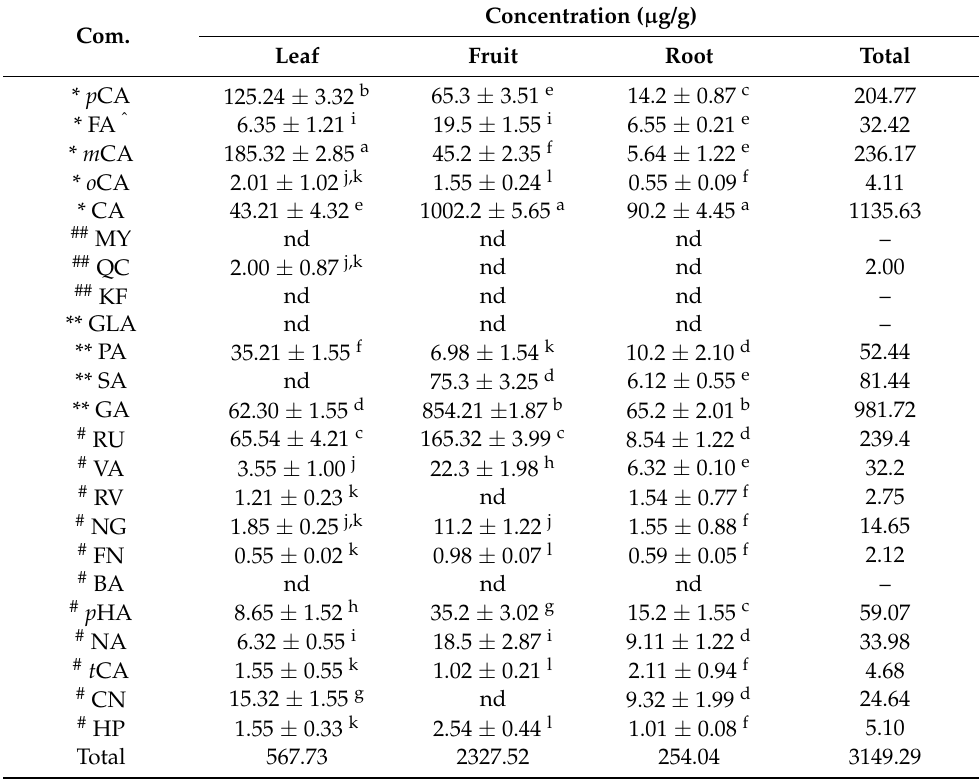
Table 2. Major phenolic compounds identified in the different parts of P. ginseng extract by UHPLC